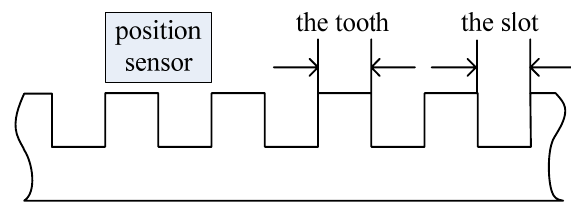
Figure 4. The position sensor and the long